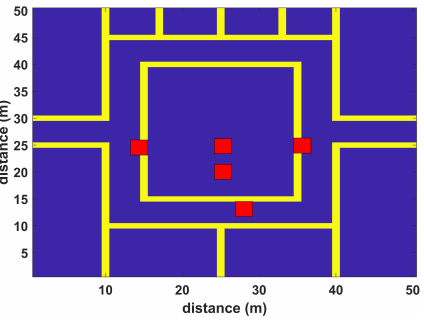
Figure 5. Floor map with 50 m by 50 m dimensions. Table 1. WLAN access point configurations.